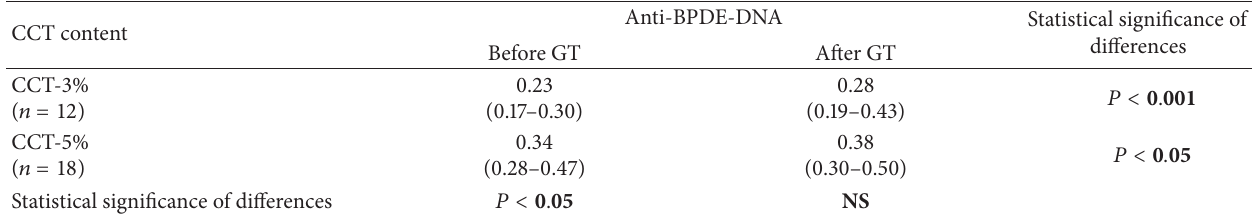
Table 2: The serum level of anti-BPDE-DNA before and after the therapy (nonsmokers). CCT